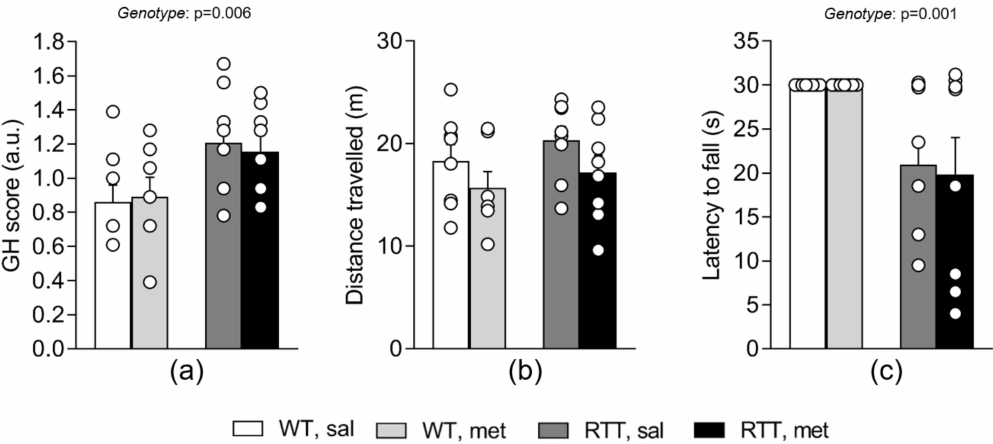
Figure 7. A 10-day long treatment with metformin does not a ff ect the compromised general health (GH) status and motor dysfunction of RTT mice. RTT female mice received higher scores compared to WT mice in the GH evaluation ( a ), confirming the presence of phenotypic alterations. No treatment e ff ects were found on this parameter. Total distance moved in the open field test ( b ) does not